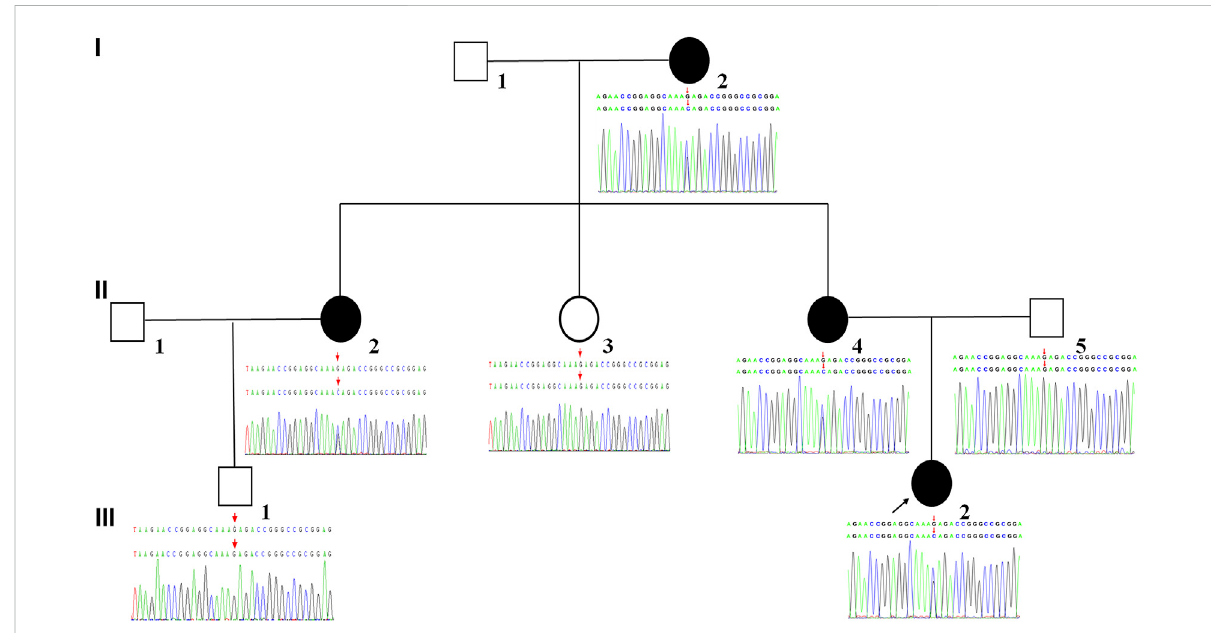
FIGURE 1 Pedigree ofthefamilyaffectedbyNS-UHL. Whitesymbolsindicatenormalindividuals.The fi lledblacksymboldenotestheindividualdiagnosed with NS-UHL. The arrow indicates the proband of the